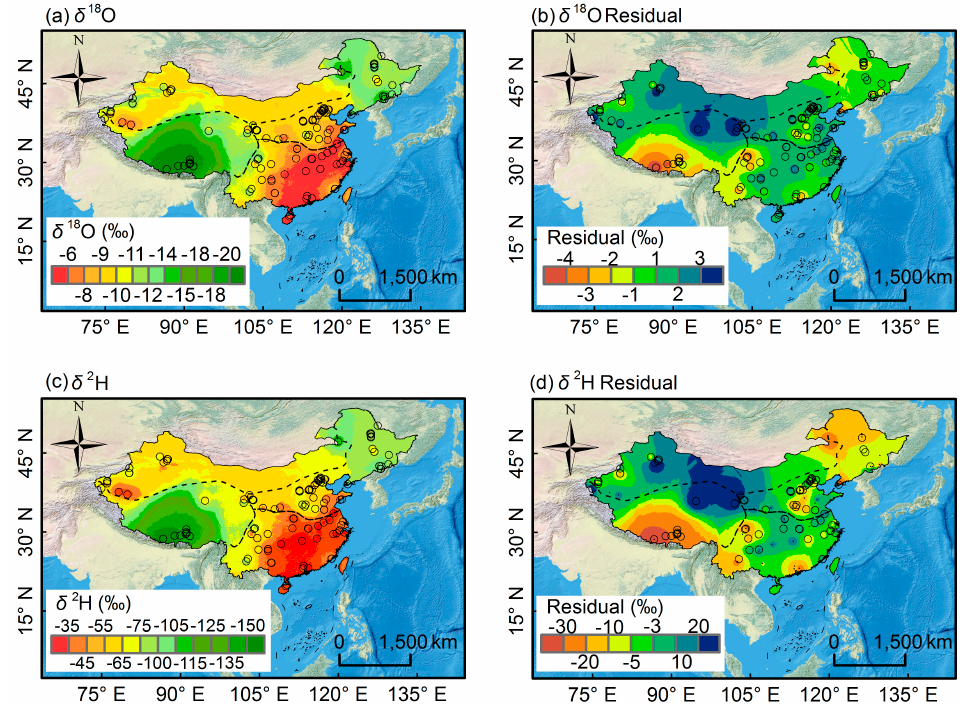
Figure 3. Spatial distribution of δ 2 H and δ 18 O values of bottled water and residuals (observation minus estimate) across China. Sub-region boundaries and base map as for Figure 1.